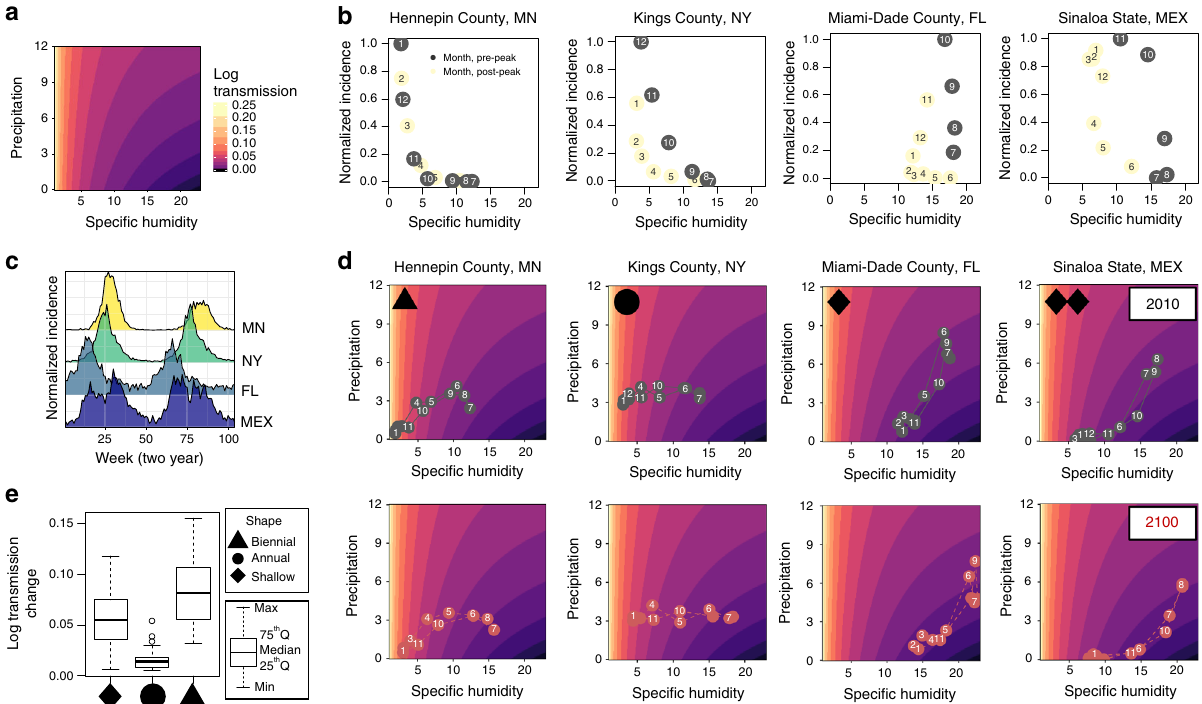
Fig. 2 Speci fi c humidity and precipitation drive RSV transmission. a Model results for the predicted effect of speci fi c humidity and precipitation on transmission. b Normalized monthly RSV cases before peak incidence (gray) and after peak incidence (yellow) against mean monthly humidity for four locations in the dataset, month-of-year shown in point. c Mean incidence averaged biennially for the same four locations demonstrating distinct dynamic patterns. d Seasonal trajectory in terms of humidity and precipitation for same locations in 2010 and 2100, month-of-year shown in point. e Boxplot showing seasonal change in transmission grouped by dynamic